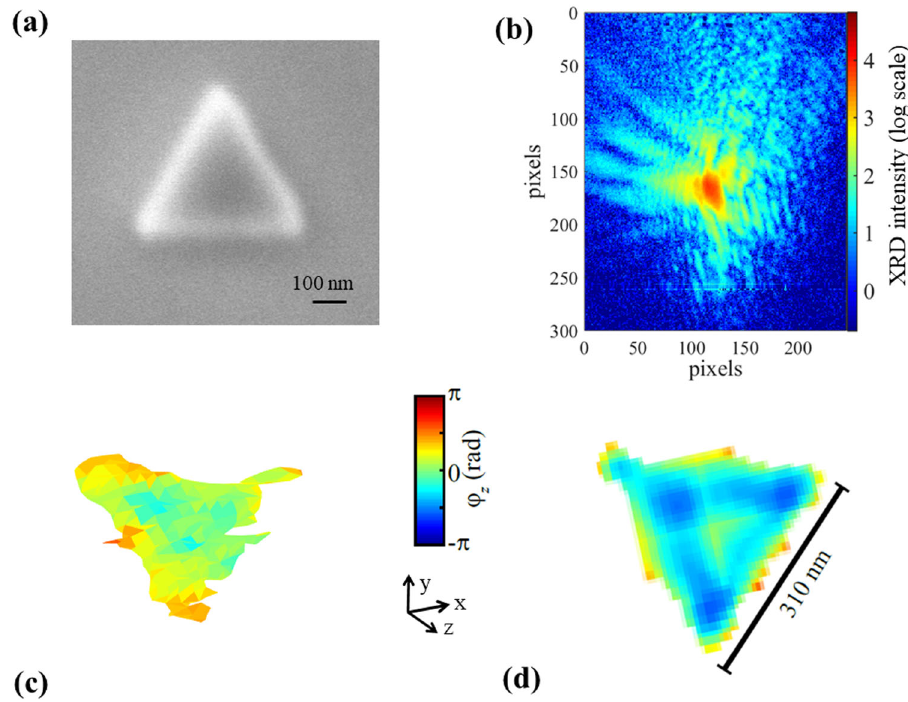
Fig. 5 BCDI and FEA of a structure fabricated with a 500-nm-side triangular mask and using the y = 4.2% GaAs 1 − y N y epilayer. a SEM image of the 500-nm-side hydrogen-opaque mask used to produce the GaAs 1 − y N y triangular structure. b XRD pattern taken at the peak of the GaAs 1 − y N y [004] rocking curve by a 55- µ m-pixel MAXIPIX 2D detector. Intensity color map (right side) is in logarithm scale given as power of 10. c Reconstruction of the phase of the complex density function, producing a 3D map of the out-of-plane strain; the phase is represented by the phase values that intersect the amplitude isosurface obtained at 35% of the amplitude maximum, the color scale has radians units. Resolution of the reconstructed image is about 25 nm, pixel size is 22 nm. d FEA simulation corresponding to the phase rendering of c